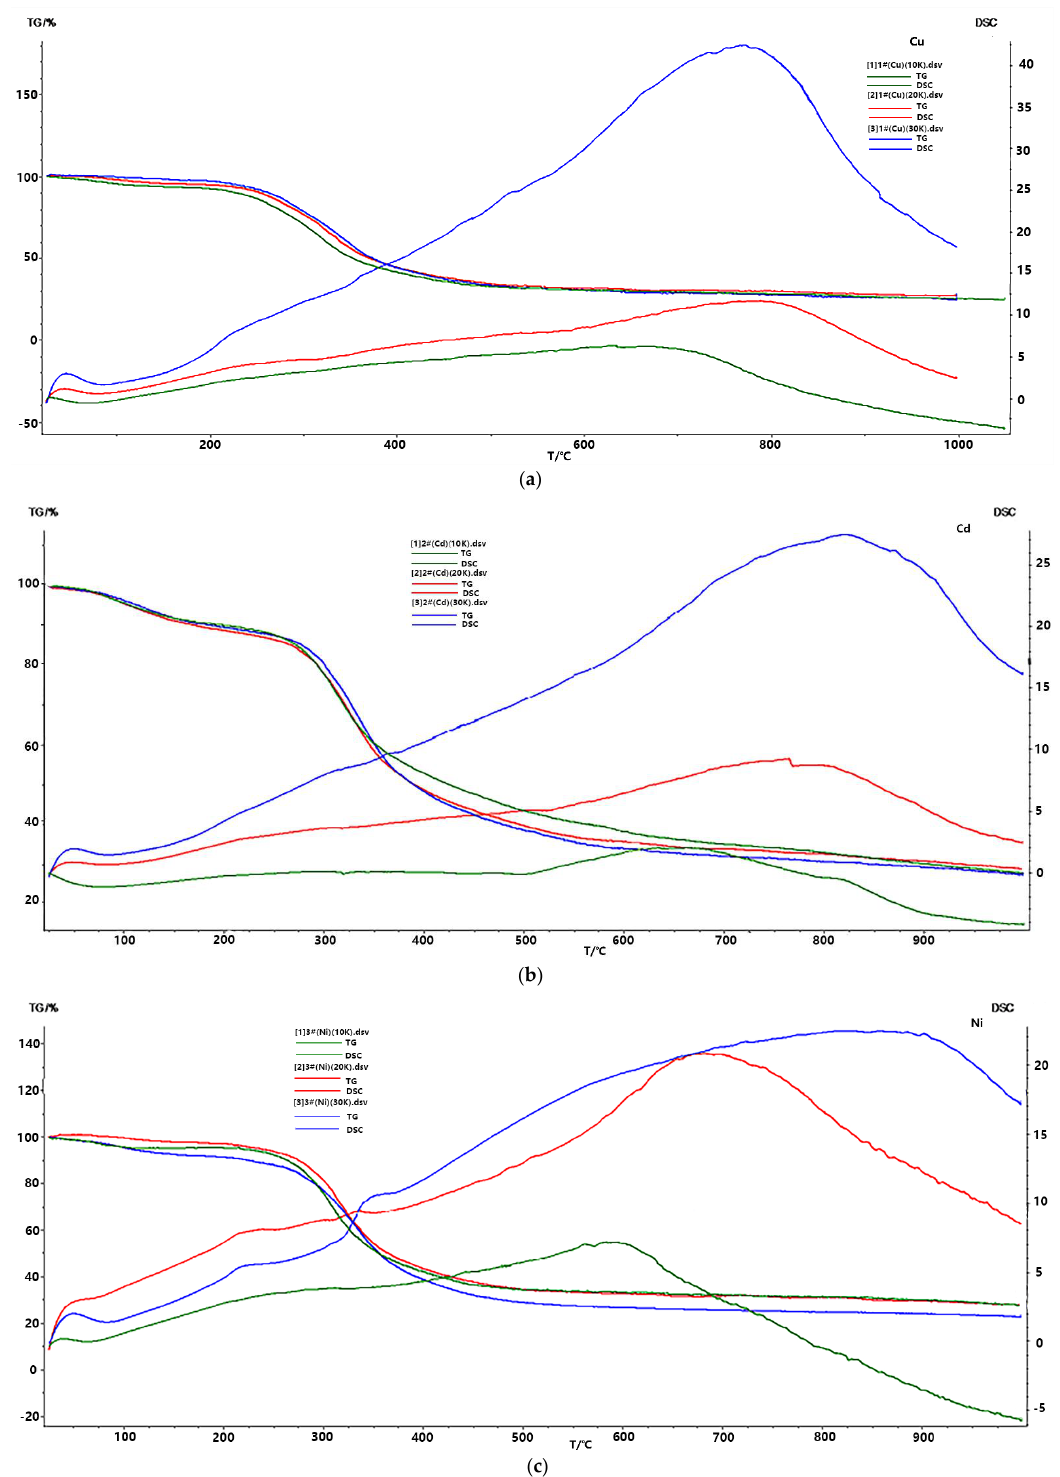
Figure 3. TG-DSC diagram of Microcystis aeruginosa before and after adsorption of copper, cadmium and nickel ions. ( a ) TG-DSC diagram of Microcystis aeruginosa before and after adsorption of copper ions; ( b ) TG-DSC diagram of Microcystis aeruginosa before and after adsorption of cadmium ions; ( c ) TG-DSC diagram of Microcystis aeruginosa before and after adsorption of nickel ions, The green, red and blue lines represent the heating rates of 10 K/min, 20 K/min and 30 K/min, respectively.